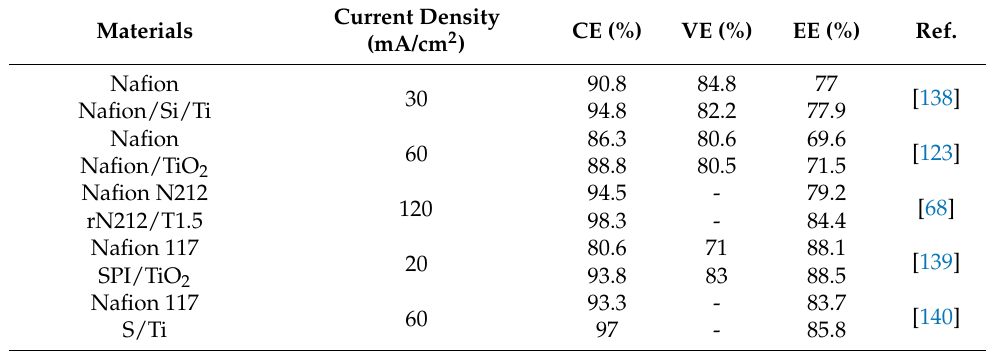
Table 2. VRFB unit cell performances (efficiencies) of different kinds TiO 2 based nanofillers incorpo- rated hybrid